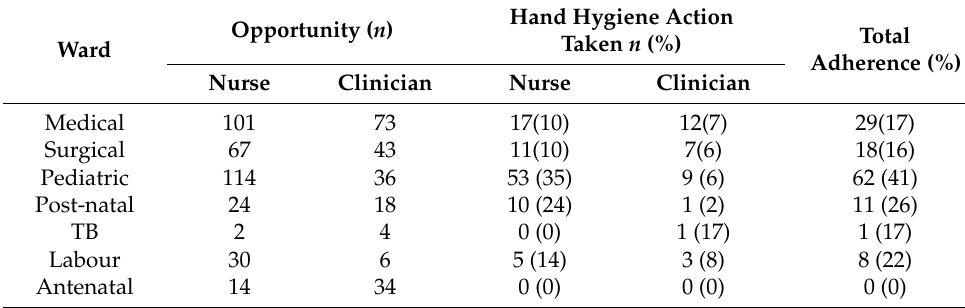
Table 3. Hand hygiene adherence in the hospital